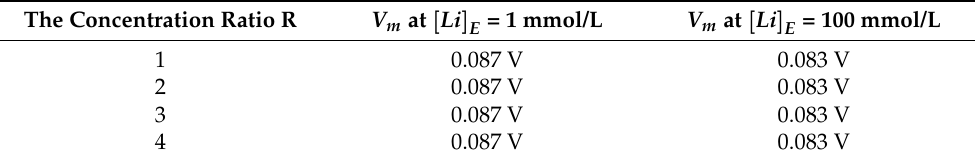
Table 18. The table shows the membrane potential values at extracellular lithium concentration of 1 mmol/L and 100 mmol/L, at different concentration ratios R and based on the classical transport of both isotopes as in graph (a) of Figure 8.